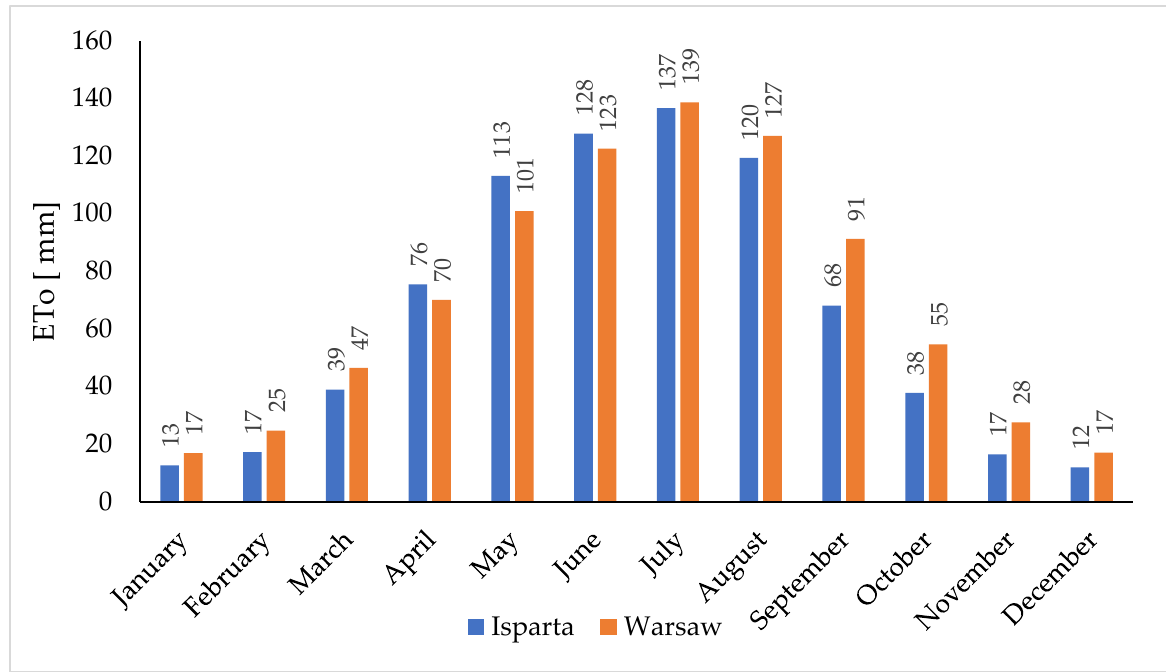
Figure 2. Change in ETo for both regions by month.